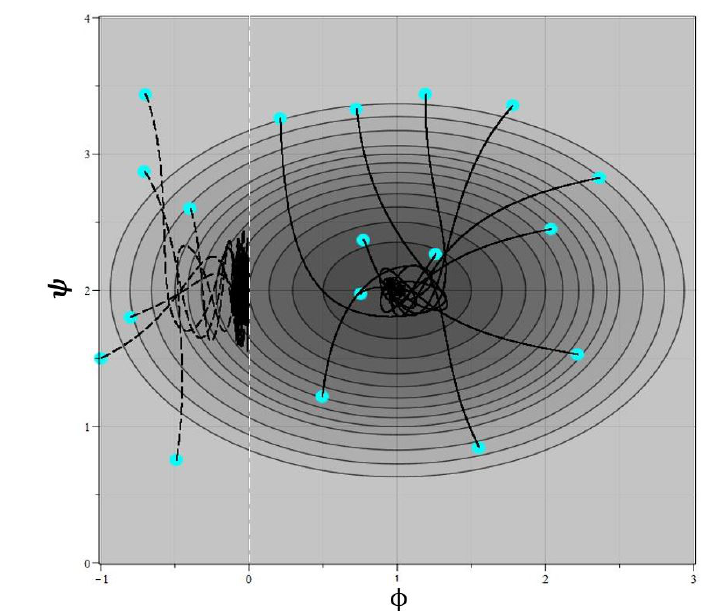
Figure 4. Isolines of the interaction potential (47) together with the phase trajectories of the model.